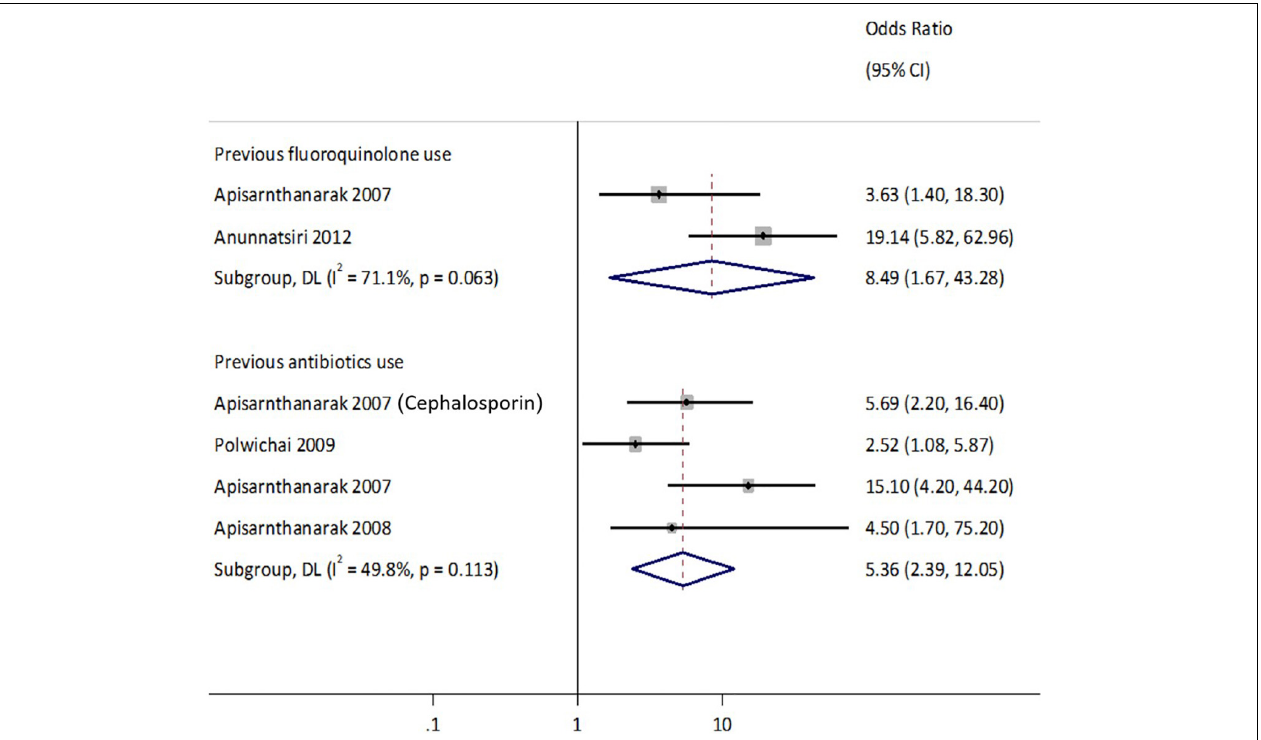
FIGURE 7 | Forest plot of the risks factor associated with ESBL Enterobacterales. Carriage studies. Forest plots from the fixed-effects meta-analyses of studies showing the individual and pooled odds ratios for the association between (1) presence of comorbidities (top), (2) chronic kidney disease (mid), and (3) previous antibiotics use (bottom) and the isolation of Enterobacteriaceae (ESBL-E and CPE) from clinical and non-clinical specimens. The gray shaded box on the individual point estimates represents the relative weight of each individual study contributes to the pooled